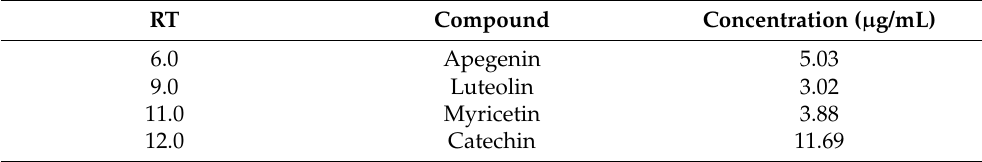
Table 2. HPLC flavonoids data of G. biloba leaves.